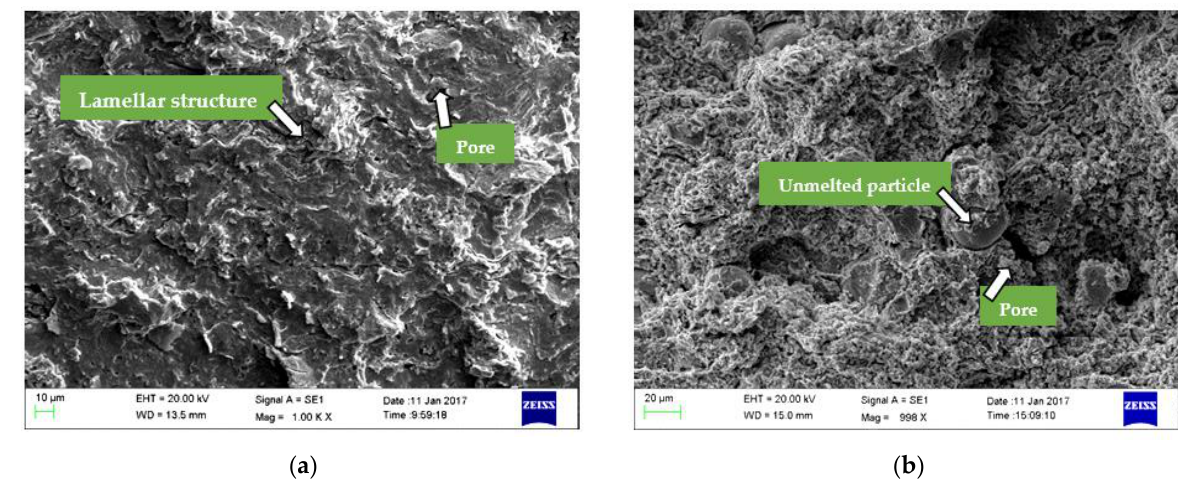
Figure 4. SEM photos of the fractured cross sections. ( a ) the shrouded plasma-sprayed Ti coating, ( b ) the unshrouded plasma-sprayed Ti coating.